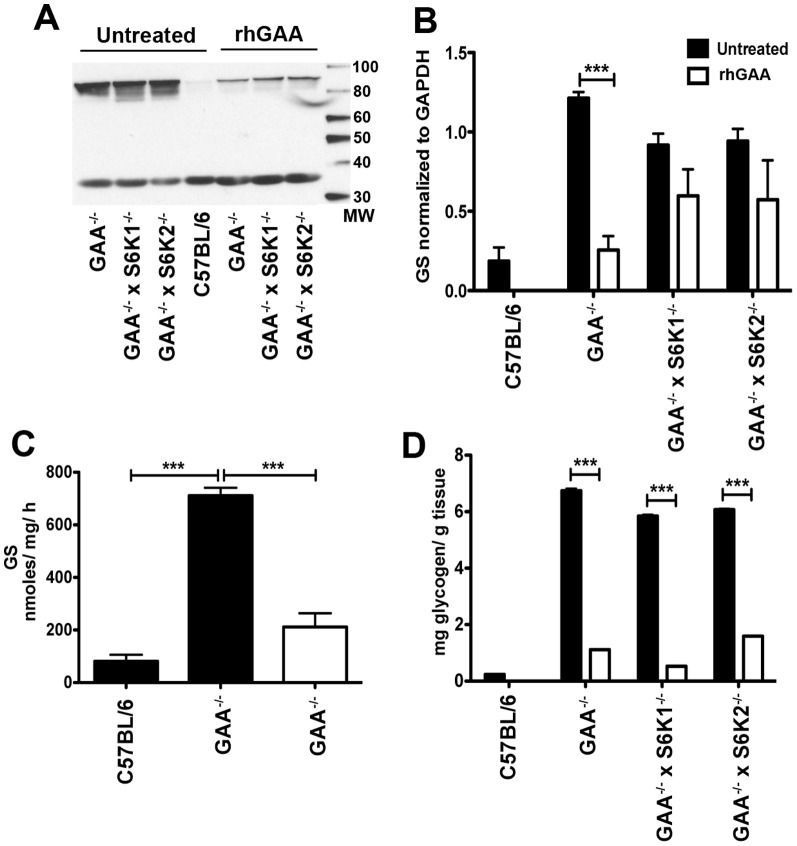
rhGAA treatment reduces glycogen synthase protein and activity levels in triceps of GAA−/− mice.Triceps were analyzed as described in the legend to Figure 4.